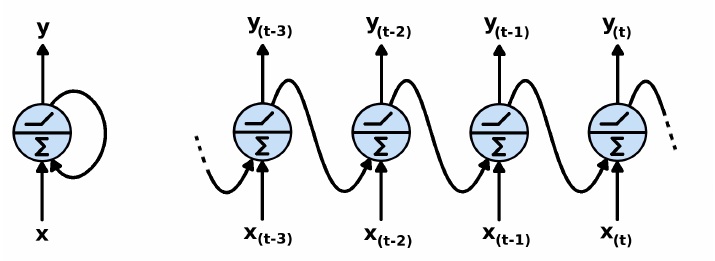
Figure 2. Recurrent architecture and the unfolding in time. Recurrent nodes have connections which lead to the next node, and connections which loop back to the same node. The unfolding in time shows the same node in three consecutive iterations.